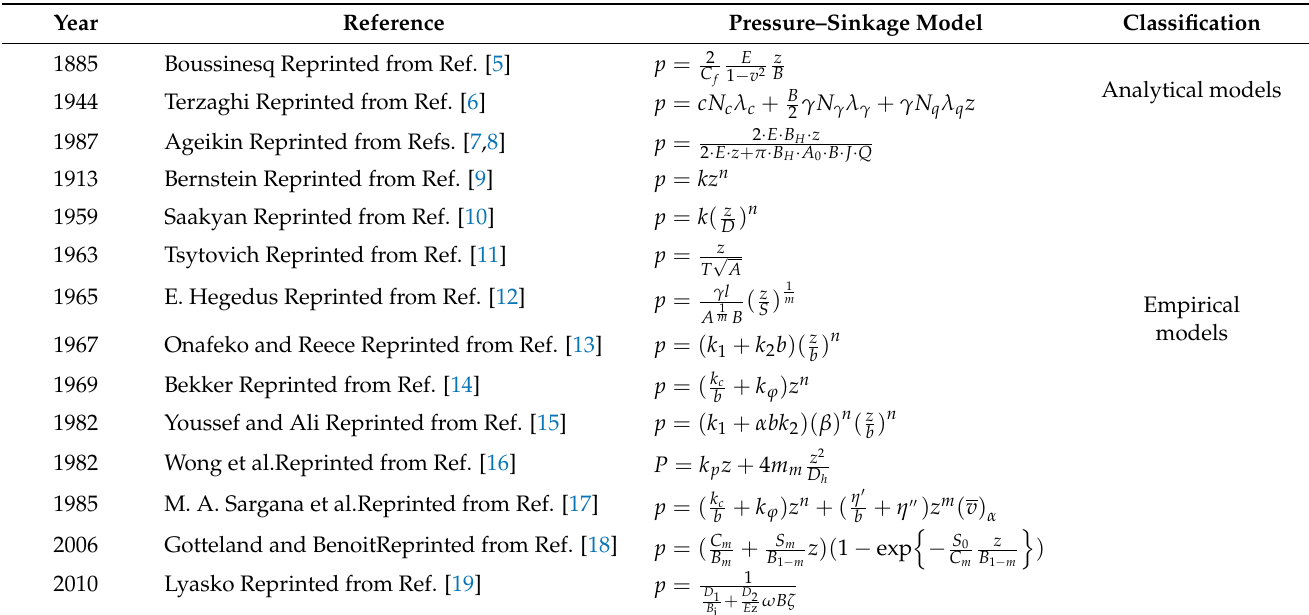
Table 1. Summary of pressure–sinkage models in the